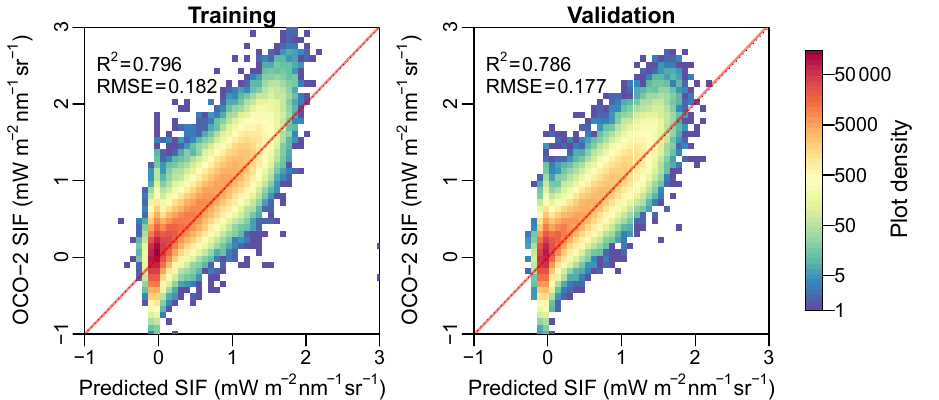
Figure 2. Predicted SIF in comparison with the OCO-2 SIF. Red lines represent the regression slope and the black dotted lines represent the 1 : 1